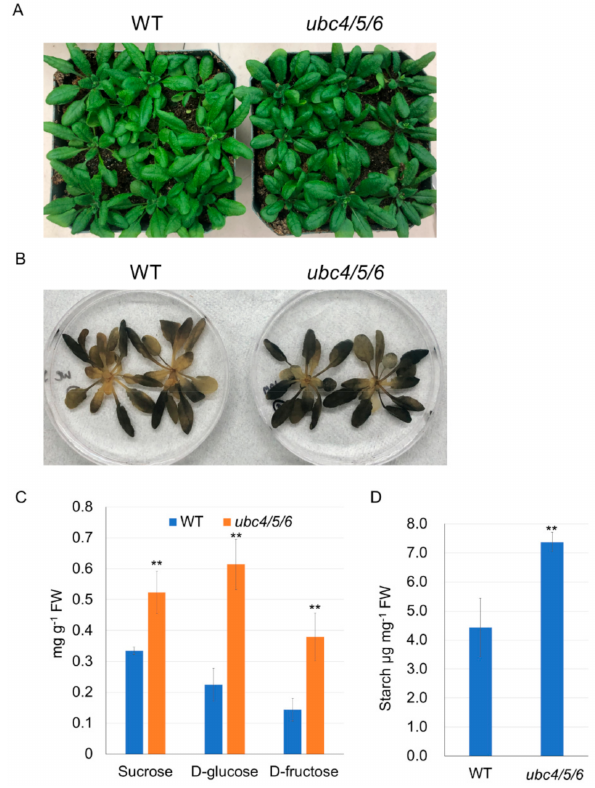
Figure 2. Plant morphology, starch and sugar analyses of the WT and ubc4/5/6 triple mutant. ( A ) Image to show the WT and ubc4/5/6 mutant plants at the 5-week stage. ( B ) Starch iodine staining of the WT and ubc4/5/6 mutant plants. Five-week-old plants were harvested during the day, stained with Lugol solution for 2 min, and cleared for observation. ( C ) Quantitative analyses of sucrose, glucose, and fructose levels in the WT and the ubc4/5/6 mutant. About 100 mg of leaf tissues from 3-week-old plants were used for extracting soluble sugars. Each datum (in mg of sucrose, glucose, or fructose per gram of fresh tissues) represents the average of four biological replicates (error bar = standard deviation). Student’s t -test was performed to determine whether there is a significant difference (**: p < 0.01). ( D ) Quantification of the starch level in the WT and ubc4/5/6 mutant. About 100 mg of leaf tissues from 3-week-old plants were used for the starch analysis. Each datum (in mg of starch per gram of fresh tissues) represents the average of four biological replicates (error bar = standard deviation). Student’s t -test was performed to determine whether there is a significant difference between the WT and mutant (**: p <